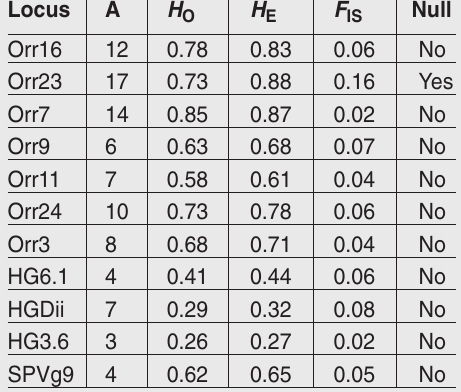
Table 1 . Number of alleles (A), observed heterozygosity ( H O ), expected